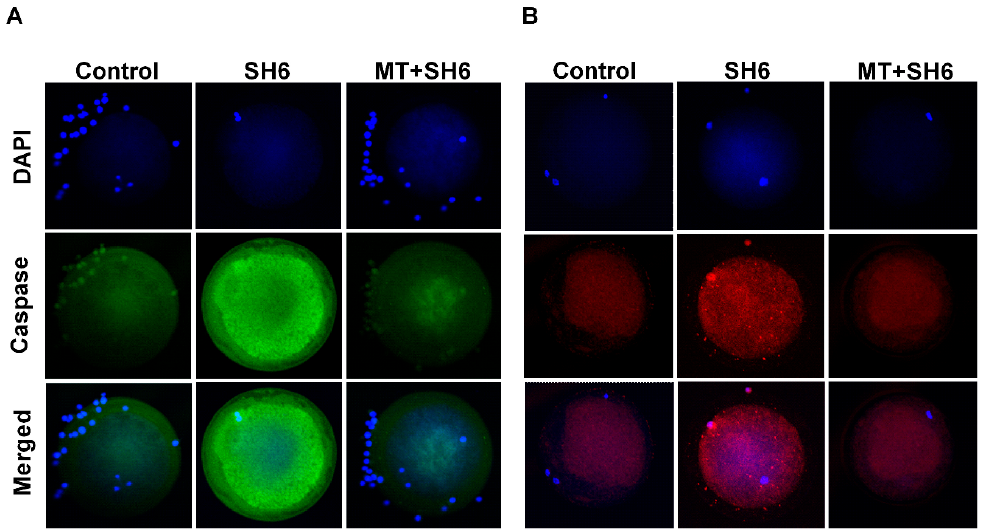
Figure 6. Determination of oxidative stress and apoptosis using ROS assay and RT-qPCR. ( A ) Microscopic determination of matured live oocytes stained with H 2 DCFDA as an indicator for intracellular ROS concentration in control and treated groups; ( B ) Fluorescent intensity analyzed by ImageJ software; ( C – F ) Relative expression of the mRNA of oxidative stress and apoptosis-related genes. Superscripts with different letters indicate statistical significance ( p < 0.05). Original magnification 200 × .